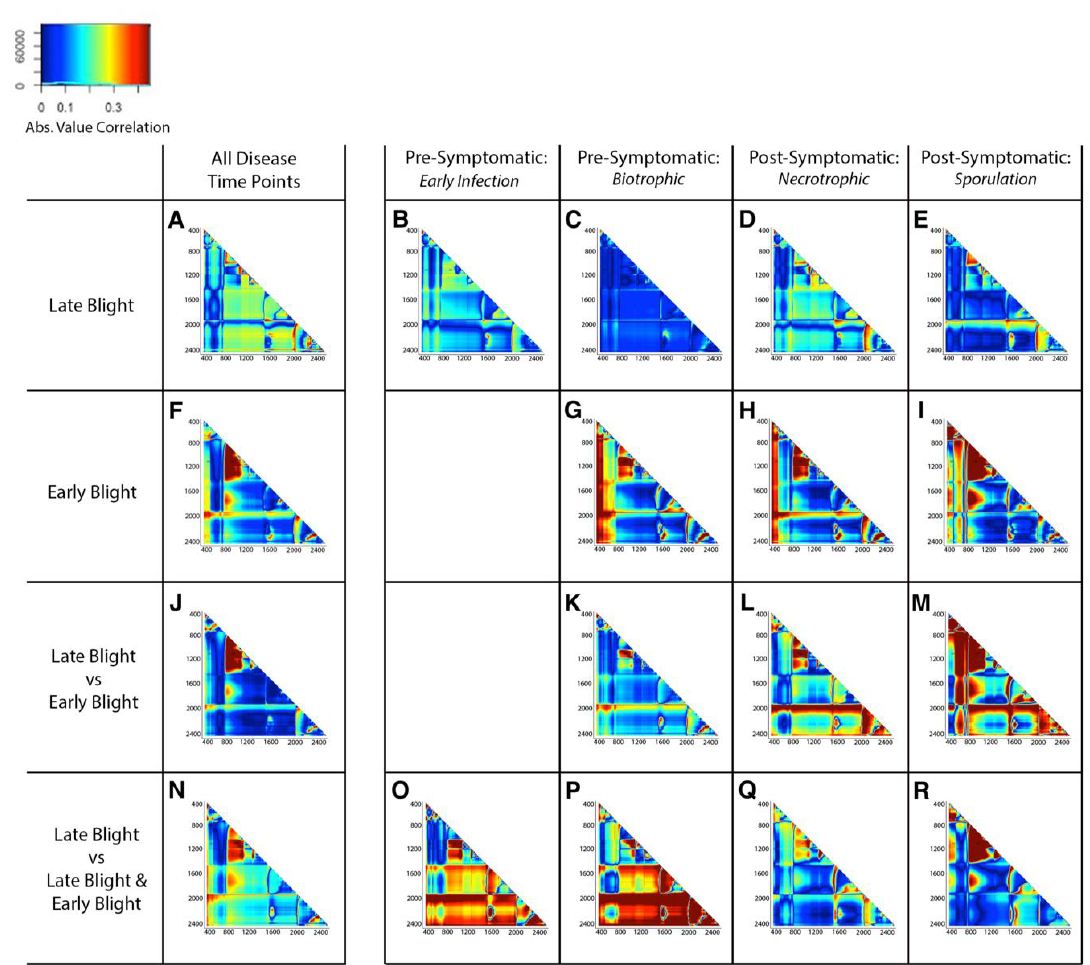
Figure 3. Heat maps of normalized differential spectral index (NDSI) correlations for binary comparisons with potato late blight (diseased vs. non-diseased, A – E ), potato early blight (diseased vs. non-diseased, F – I ), potato late blight compared to early blight ( J – M ), and potato late blight compared to mixed late blight and early blight infections ( N – R ) over all disease time points ( A , F , J , M ) and late blight disease time stages: early infection ( B , O ), biotrophy ( C , P ), necrotrophy ( D , Q ), and sporulation ( E , R ) and early blight disease time stages: pre-symptomatic ( G , K ), post-symptomatic light ( H , L ), and post-symptomatic heavy ( I , M ).